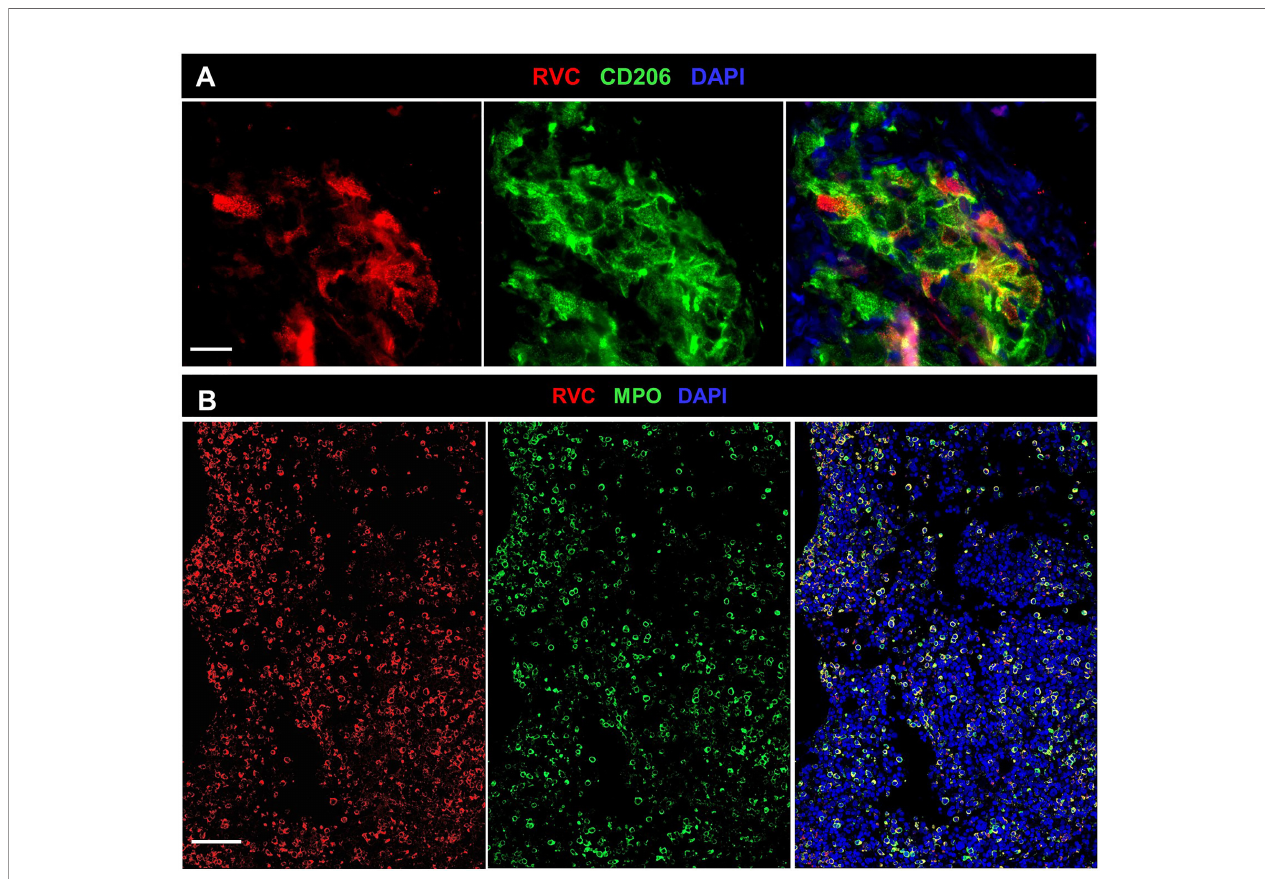
FIGURE 8 | RuV in bone marrow. Histological immuno fl uorescent staining of bone marrow core biopsies of P4 (A) and P21 (B) for RVC (A, B) and either for CD206 (A) or MPO (B) shows the presence of RuV in M2 macrophages (A) and neutrophils (B) . Scale bars: 20 µm (A) and 100 µm (B)